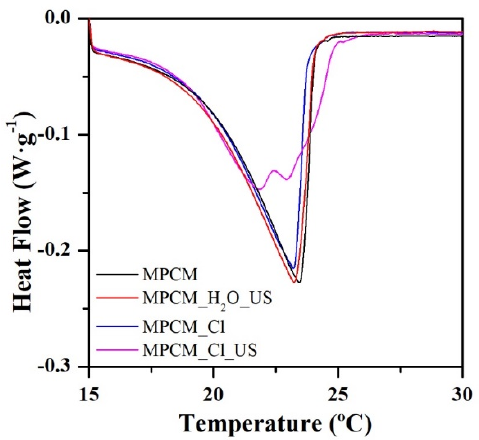
Figure 3. Heat flow curves of MPCM, MPCM_H2O_US, MPCM_Cl, and MPCM_Cl_US samples. To corroborate that MPCM shells were broken, samples were observed with SEM.